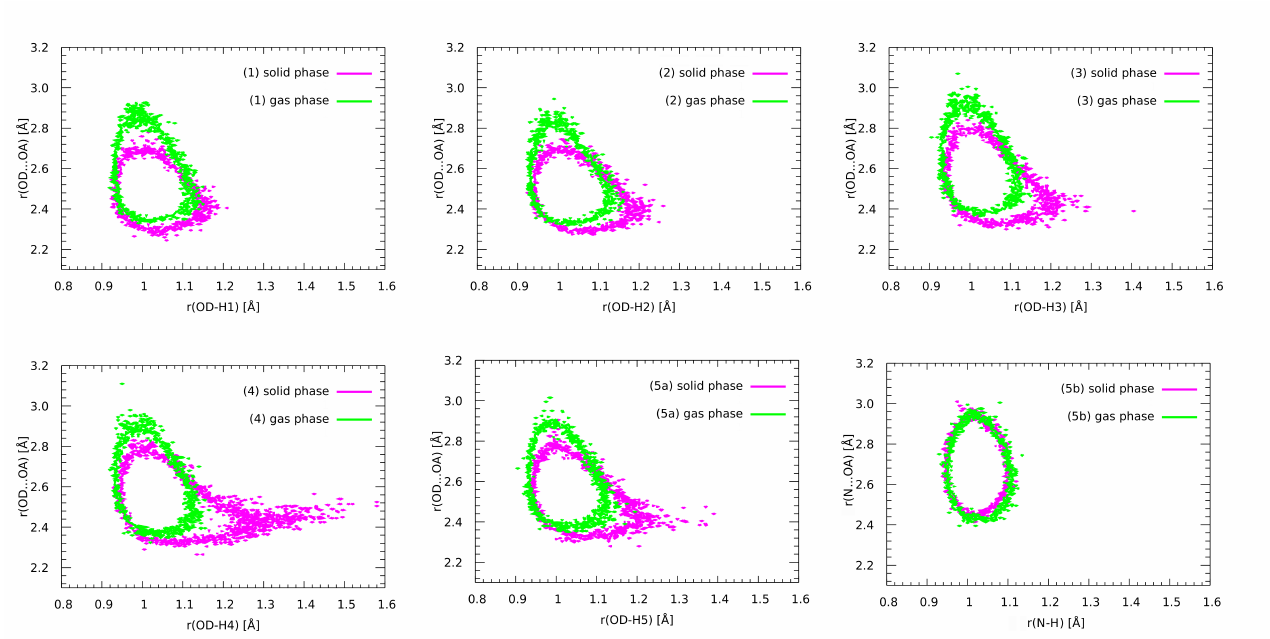
Figure 6. Relationships between the OD•••OA and OD–Hn distances for the examined compounds in the gas and solid phases. Probability density isocontours drawn at the 1 Å − 2